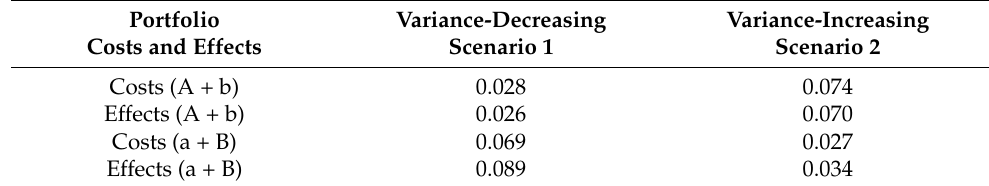
Table 3. Quartile coefficient of dispersion for costs and effects in two scenarios (using 10,000 samples) for resource reallocation (variance-decreasing Scenario 1 and variance-increasing Scenario